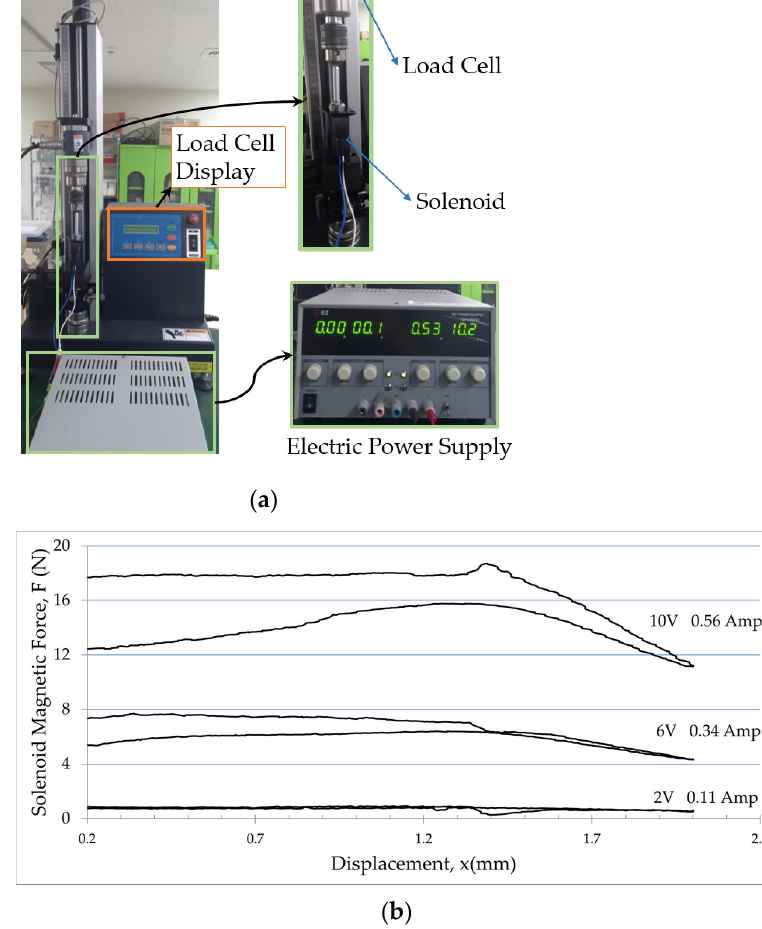
Figure 6. Solenoid actuator force measurement. ( a ) Apparatus. ( b ) Measurement Results. Table 3. Specifications of load cell used for measuring the actuating